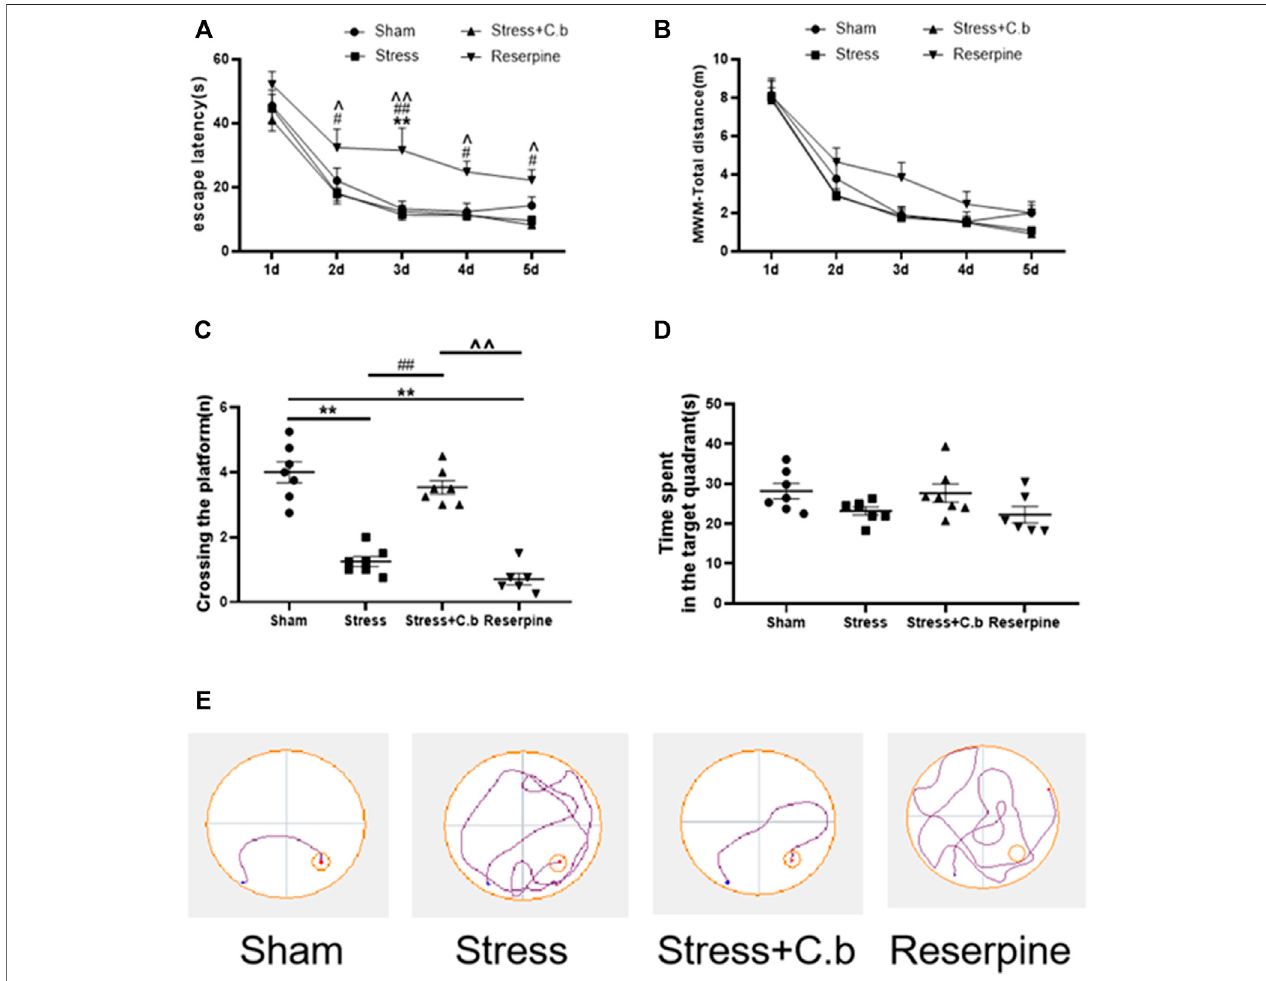
FIGURE 3 | C. butyricum treatment ameliorated the cognitive de fi cits in the CFSS rats by reversing the decreased number of crossing in target quadrant (C) but revealednoeffectsontheescapelatency (A) ,thetotaldistance (B) andtimespentinthetarget-quadrant (D) . (E) TherepresentativelocusplotintheMWMtest.Thedata are expressed as mean ± SEM (n = 7 in sham, stress, stress + C. butyricum group; n = 6 in reserpine group). * p < 0.05, ** p < 0.01 versus sham group; # p < 0.05, ## p < 0.01 versus stress group; ^ p < 0.05, ^^ p < 0.01 versus stress + C. butyricum group.